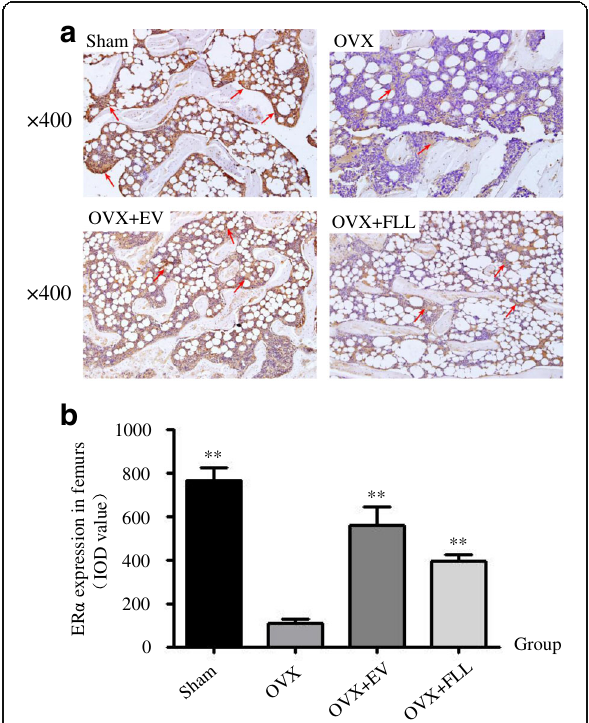
Fig. 1 The representative images ( a ) and images analysis results of immunohistochemical staining ( b ) showing the effect of FLL on ER α expression in the femurs of the rats. The arrows illustrated the expression and distribution of ER α . Data are presented as mean±SD. ** P <0.01 compared with the OVX control group